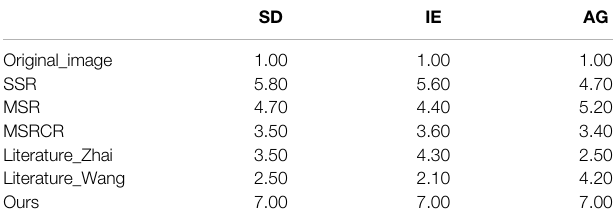
TABLE 6 | The mean of Rank at Evaluation